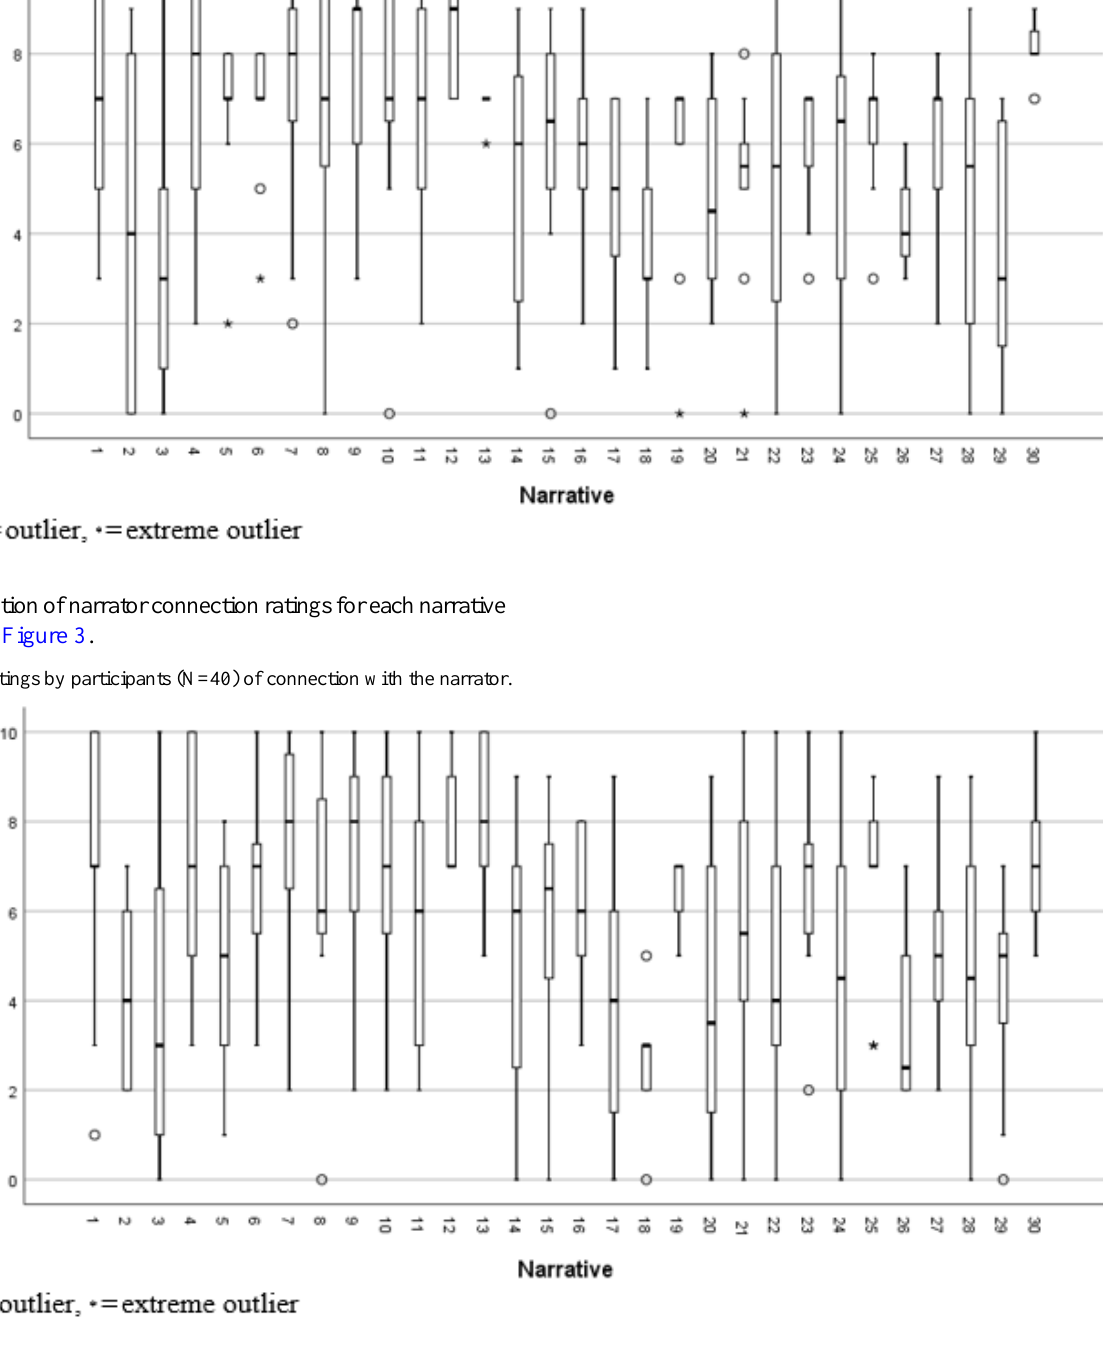
The distribution of hopefulness ratings for each narrative is shown in Figure